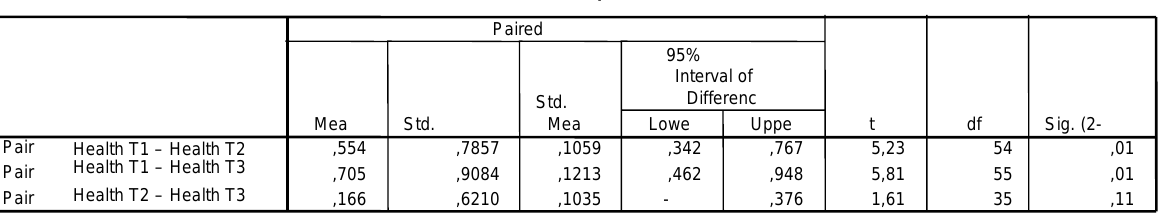
Subjective Health Significantly Improved with Clinical Holistic Medicine Paired